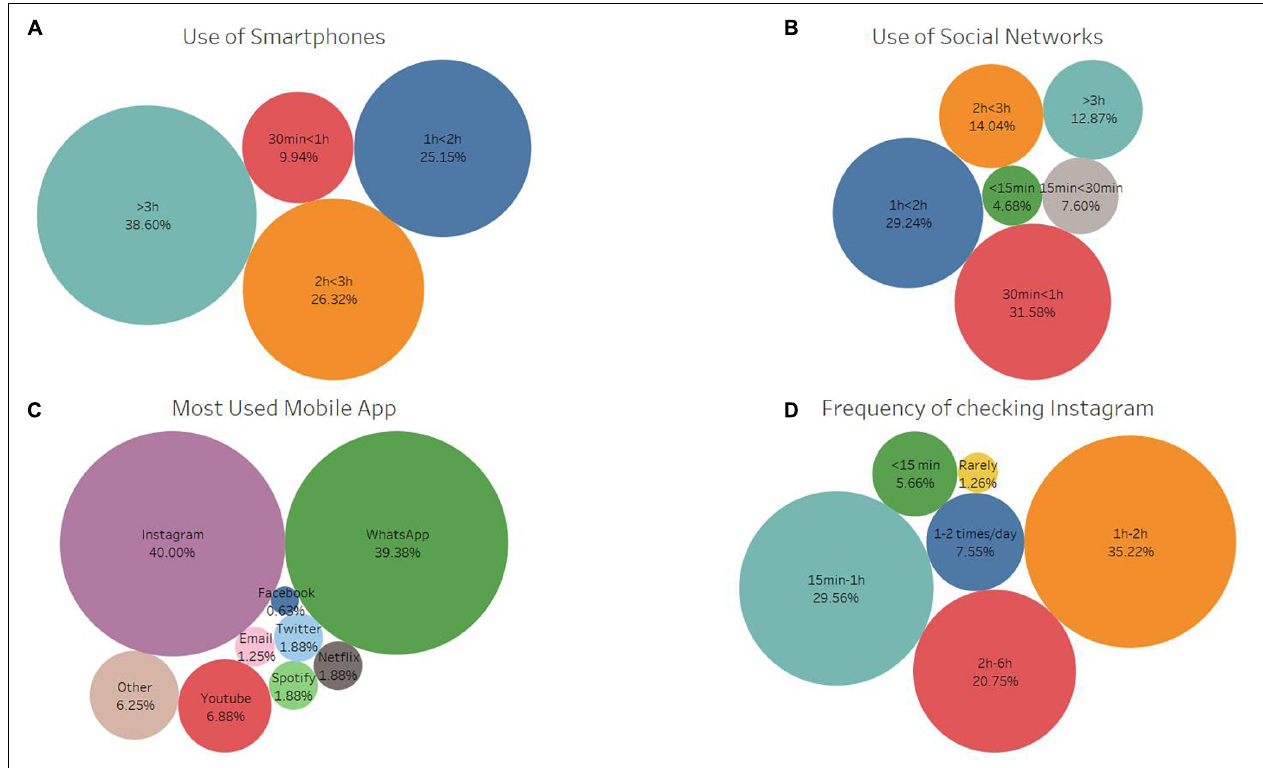
FIGURE 1 | The participants’ self-reported use of smartphones and social networks. (A,B) The daily time spent on smartphones and social networks. (C) The most used app on their smartphone. (D) The frequency of checking Instagram on a daily basis.